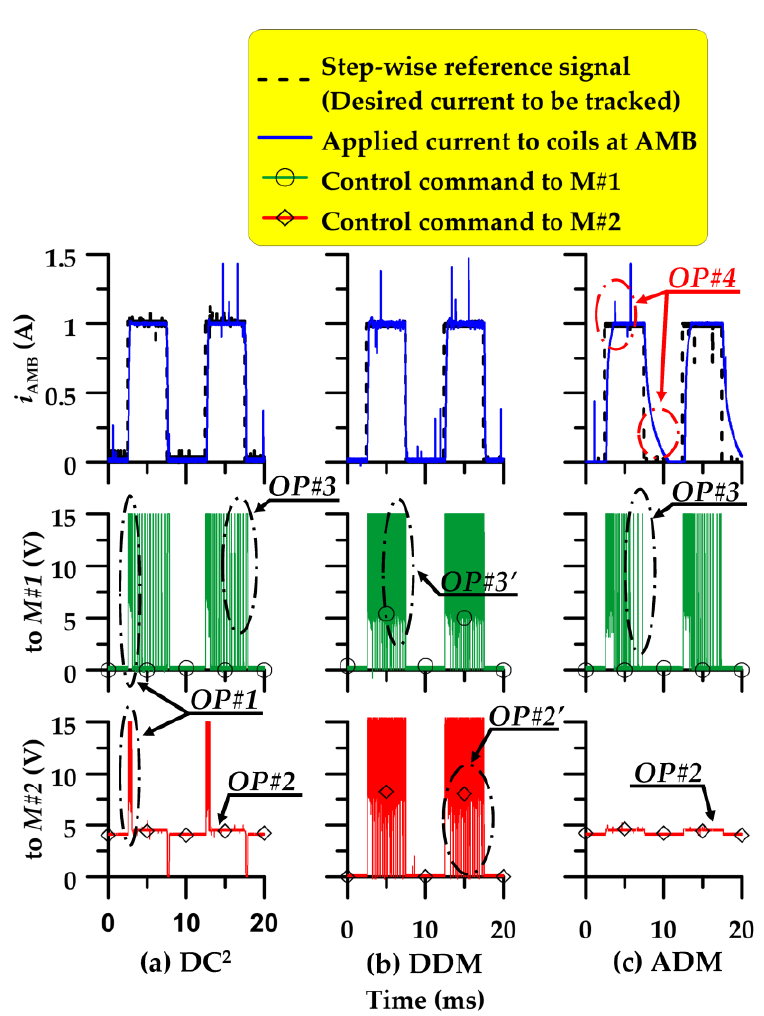
Figure 15. Experimental results: ( a ) under DC 2 (dual cooperative drive circuit); ( b ) under DDM (digital driving mode); ( c ) under ADM (analog driving mode).